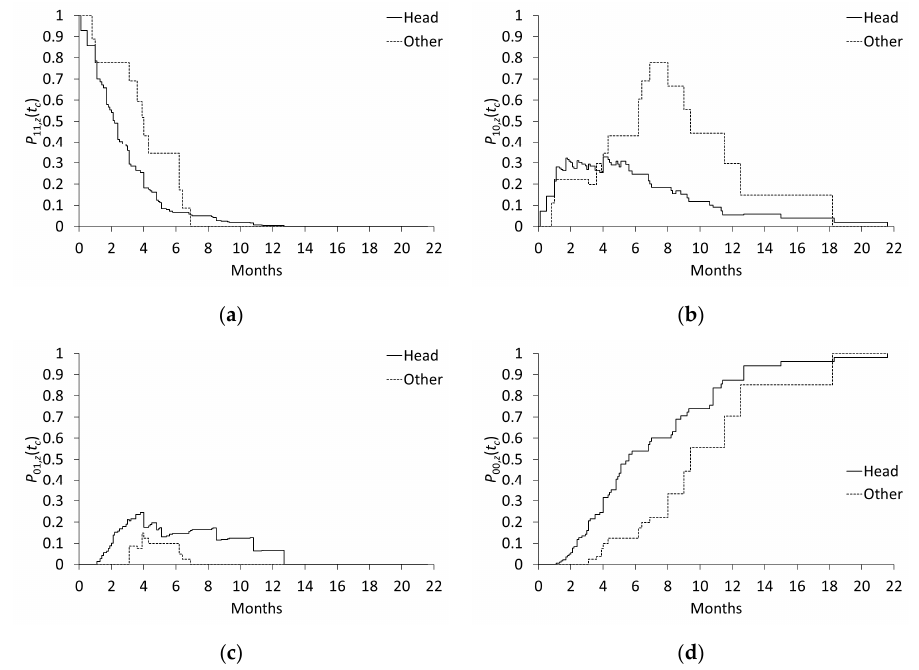
Figure 2. Response type proportions in the pancreatic head and “other” subgroups: ( a ) activated (type 11) subjects; ( b ) causative (type 10) subjects; ( c ) preventive (type 01) subjects; ( d ) inert (type 00) subjects.